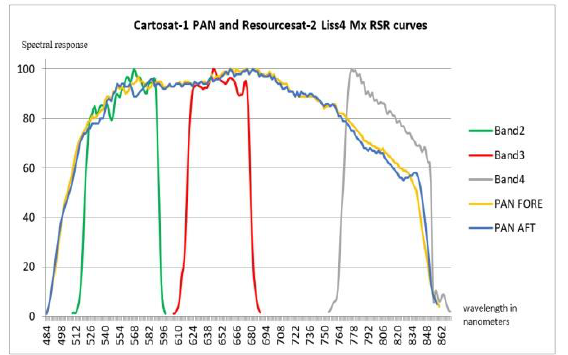
Figure 1: Spectral response of C1 PAN and RS-2